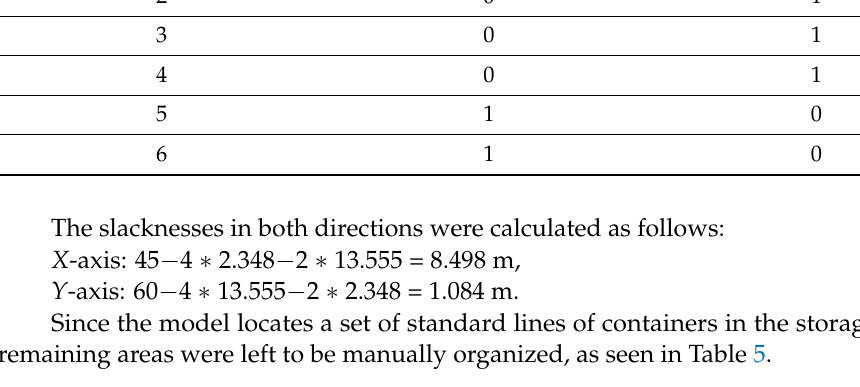
Table 4. The solution of the mathematical model for storage area optimization. Line ( i ) lx i ly i 1 0